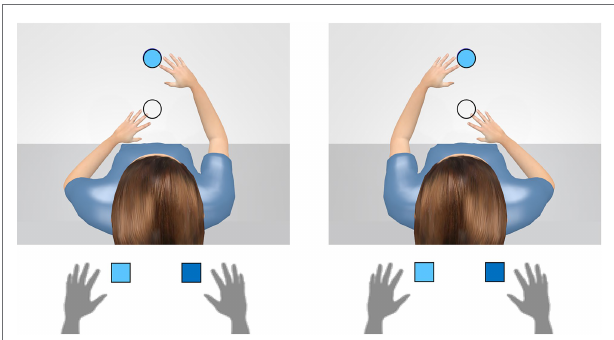
FIGURE 6 | The second scenario in the study of von Salm-Hoogstraeten et al. (2020). Participant took the first person perspective of the avatar and the avatar’s right and left hand were now at the upper and lower stimulus position. The results showed pronounced avatar-Simon effects depending on the hand position of the